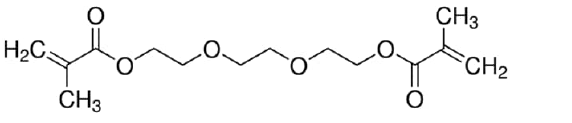
Figure 7. The chemical structure of UDMA.